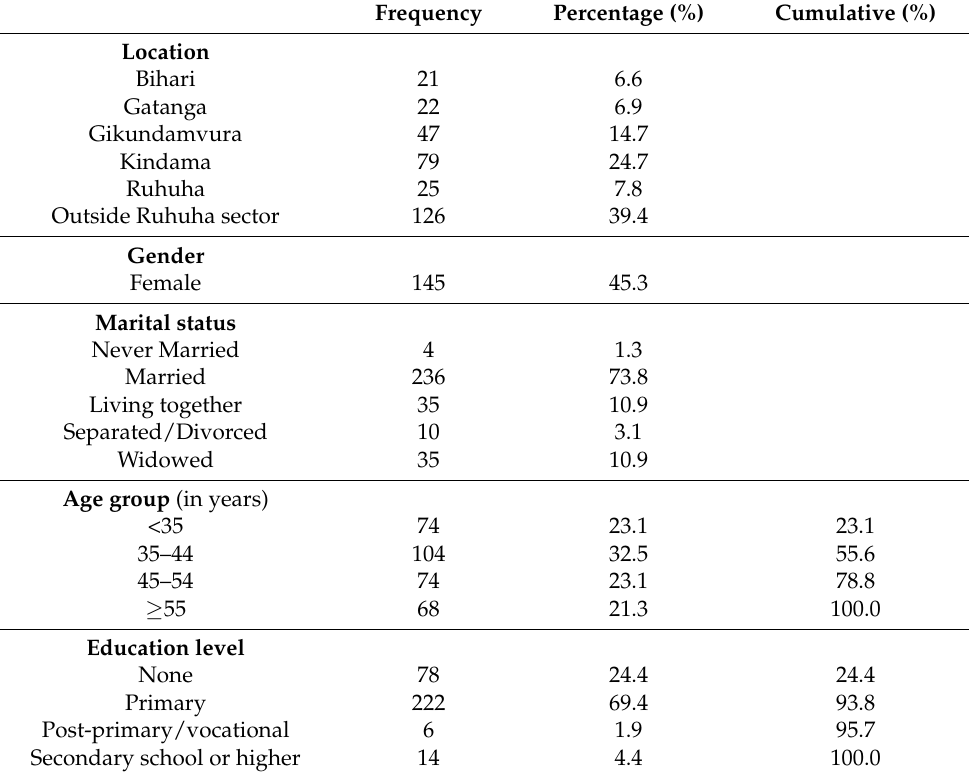
Table 1. Individual profile of rice farmer respondents ( n = 320), Ruhuha,